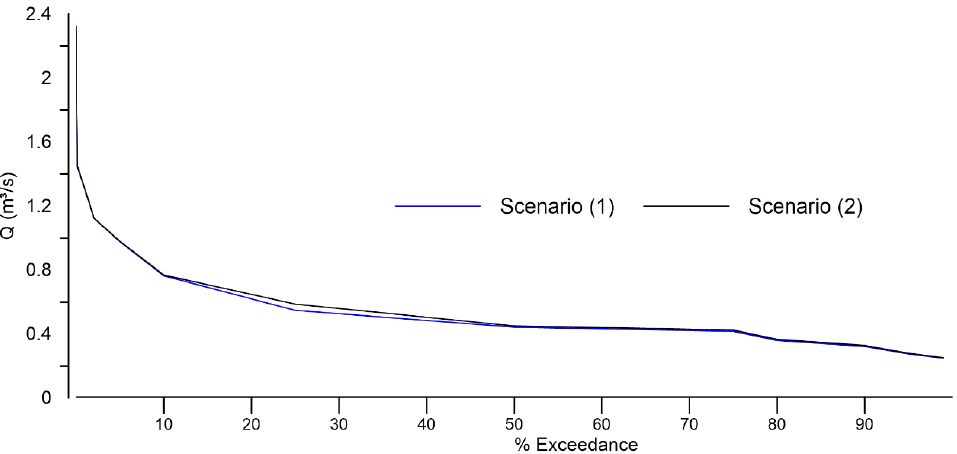
Figure 8. FDC for LULC scenarios (1) and